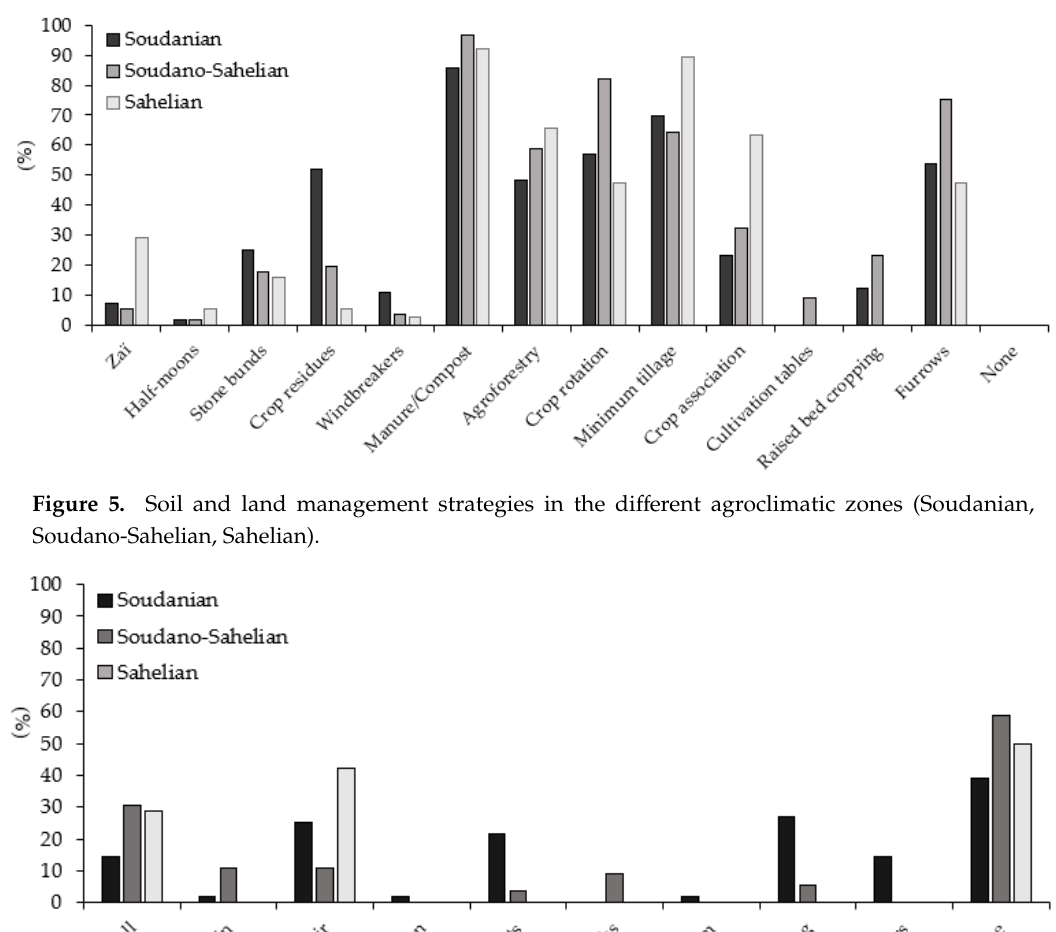
Figure 7. Use of plant growth regulators and agriculture mechanization methods in the different agroclimatic zones (Soudanian, Soudano-Sahelian, Sahelian).